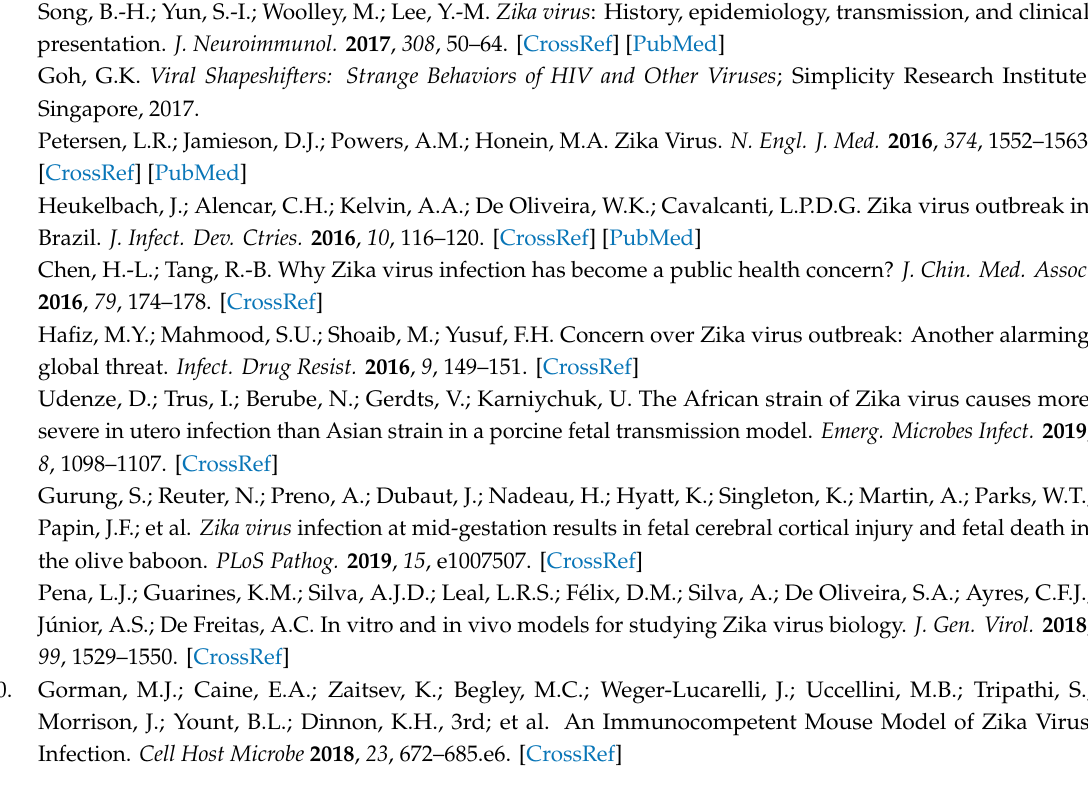
Figure S1: Line graph showing correlations between fetal morbidity and shell disorder (M and C Protein